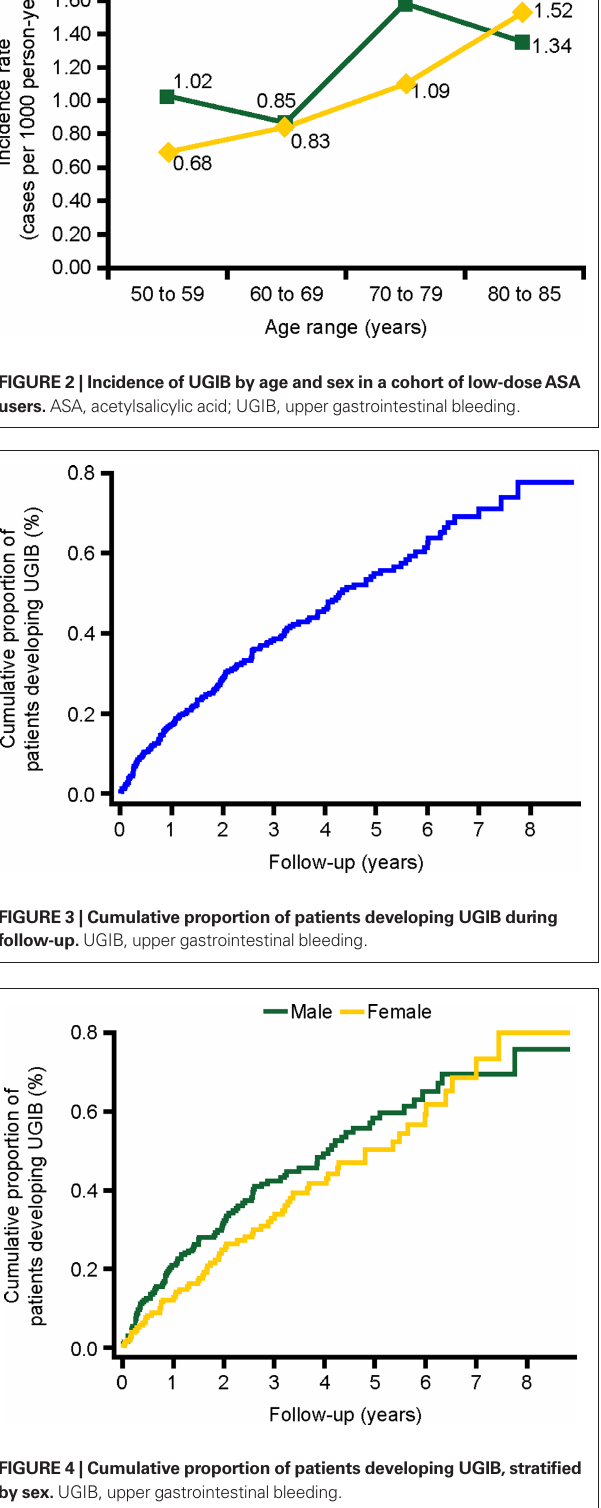
Figure 4 | Cumulative proportion of patients developing ugiB, stratified by sex. UGIB, upper gastrointestinal